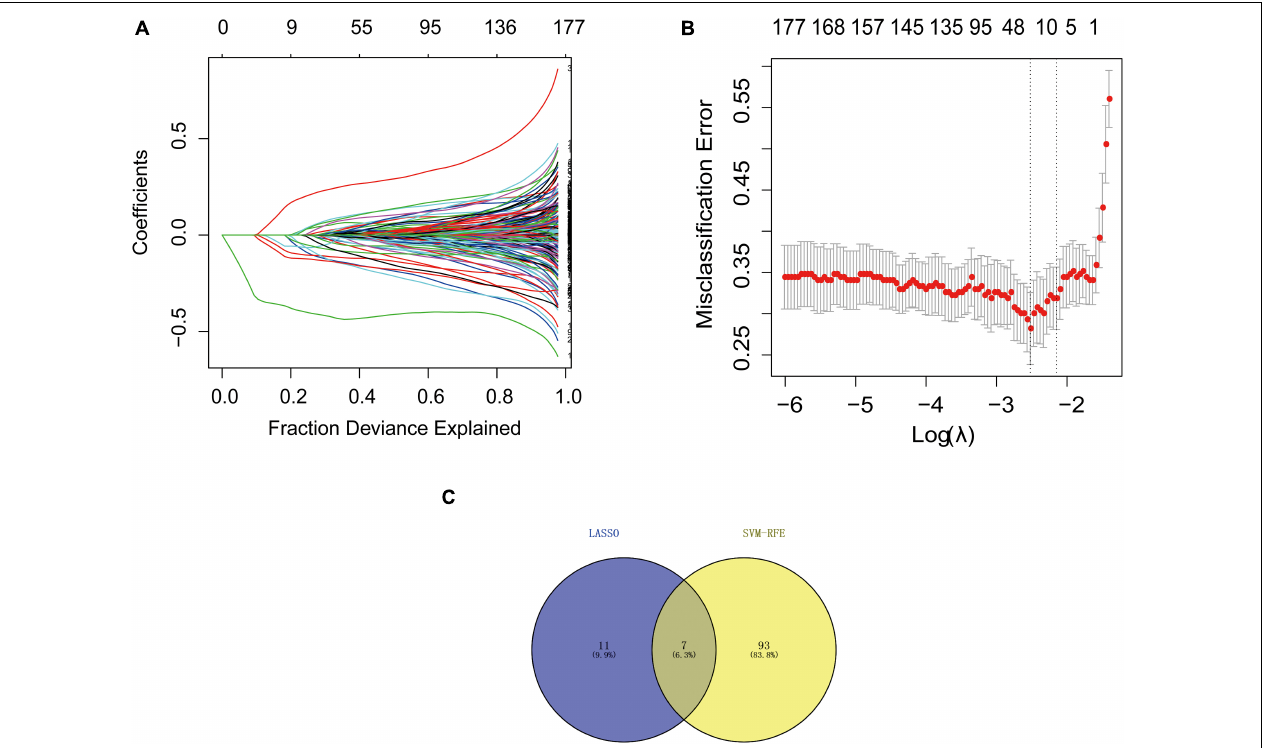
FIGURE 1 | Selection of diagnostic biomarkers and identification of hub genes. (A) LASSO coefficient profiles of the 11 genes that met the prognostic criteria initially. (B) The misclassification error in the jackknife rates analysis. (C) Venn diagram of genes extracted from LASSO and SVM-RFE methods. LASSO, least absolute shrinkage and selection operator; SVM, support vector machine; RFE, recursive feature elimination.